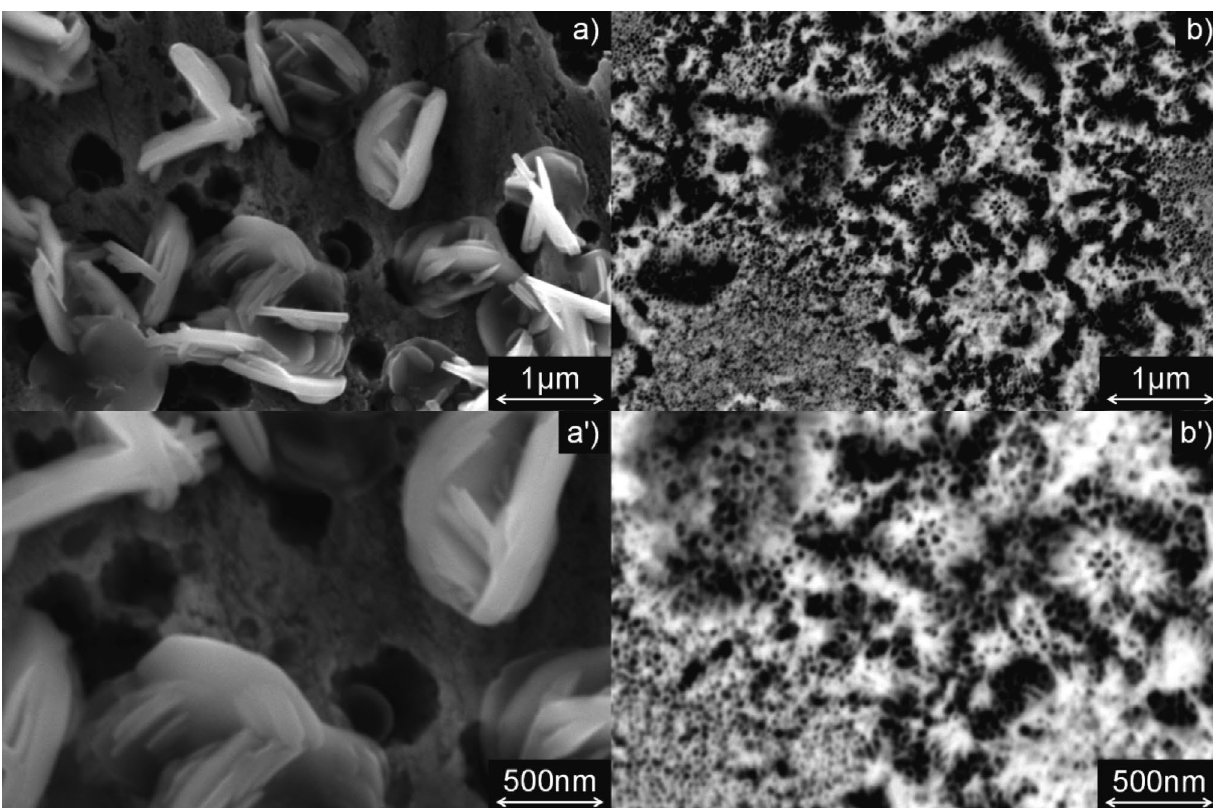
Fig.4 SEM micrographies for Zr samples anodized at 75 V in a), a’) E1; b), b’)